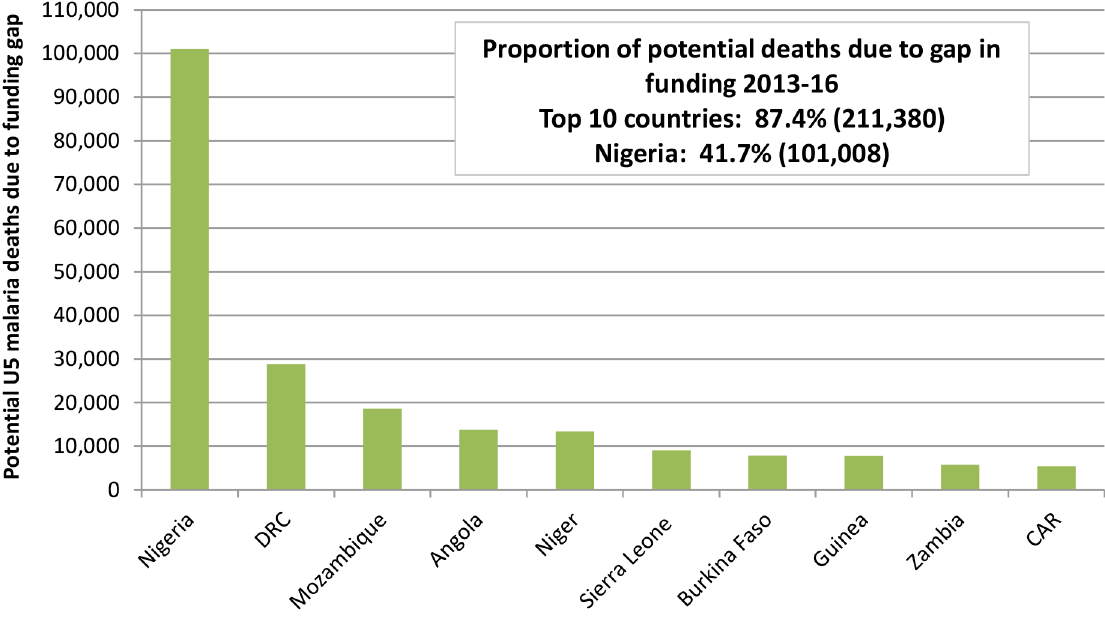
Figure 3. Ten countries with highest mortality gap due to current unmet LLIN funding need. Ten countries with highest mortality gap between what could be achieved if all LLINs were funded versus what will be achieved with current country specific funding for LLINs (CAR=Central African Republic; DRC=Democratic Republic of Congo). These ten countries account for almost 90%, or 211,380 (uncertainty range: 132,061 – 301,810) of these deaths and Nigeria alone accounts for approximately 40%, or 101,008 deaths (uncertainty range: 66,871 – 141,625). Individual country estimates of avoidable deaths (with uncertainty ranges): DRC: 28,000 (14,180 – 42,980); Mozambique: 18,569 (11,594 – 26,260); Angola: 13,779 (7,814 – 20,615); Niger: 13,409 (8,604 – 19,357); Sierra Leone: 9,023 (5,873 – 13,120); Burkina Faso: 7,856 (4,617 – 11,228); Guinea: 7,784 (5,117 – 10,786); Zambia: 5,761 (3,795 – 8,373); CAR: 5,391 (3,596 – 7,466).